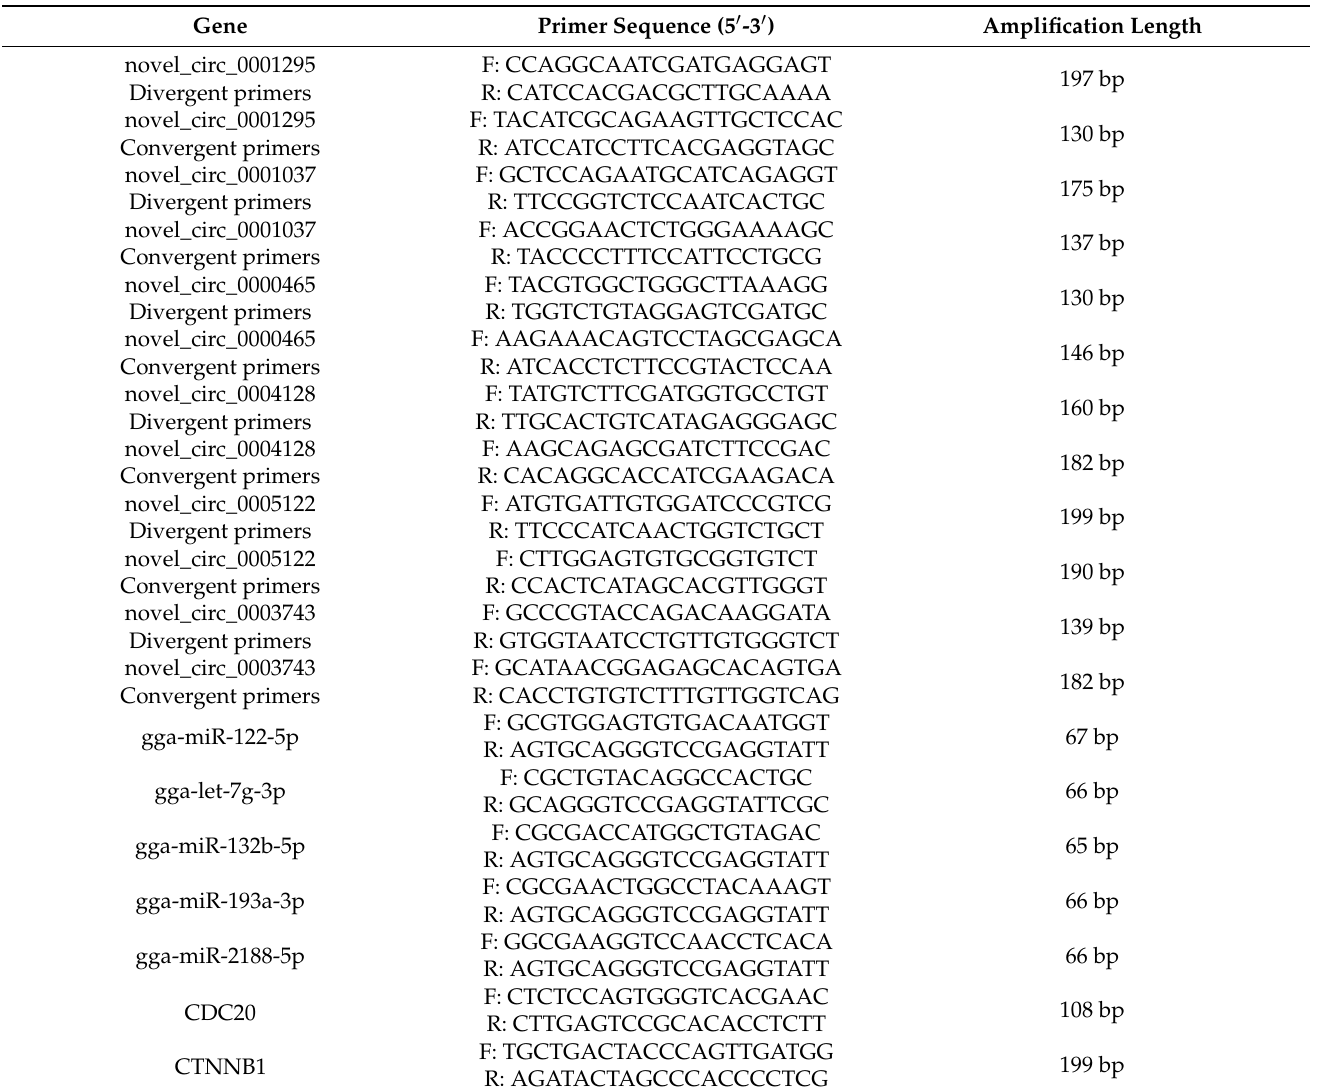
Table 1. Genes primers used in the real-time quantitative